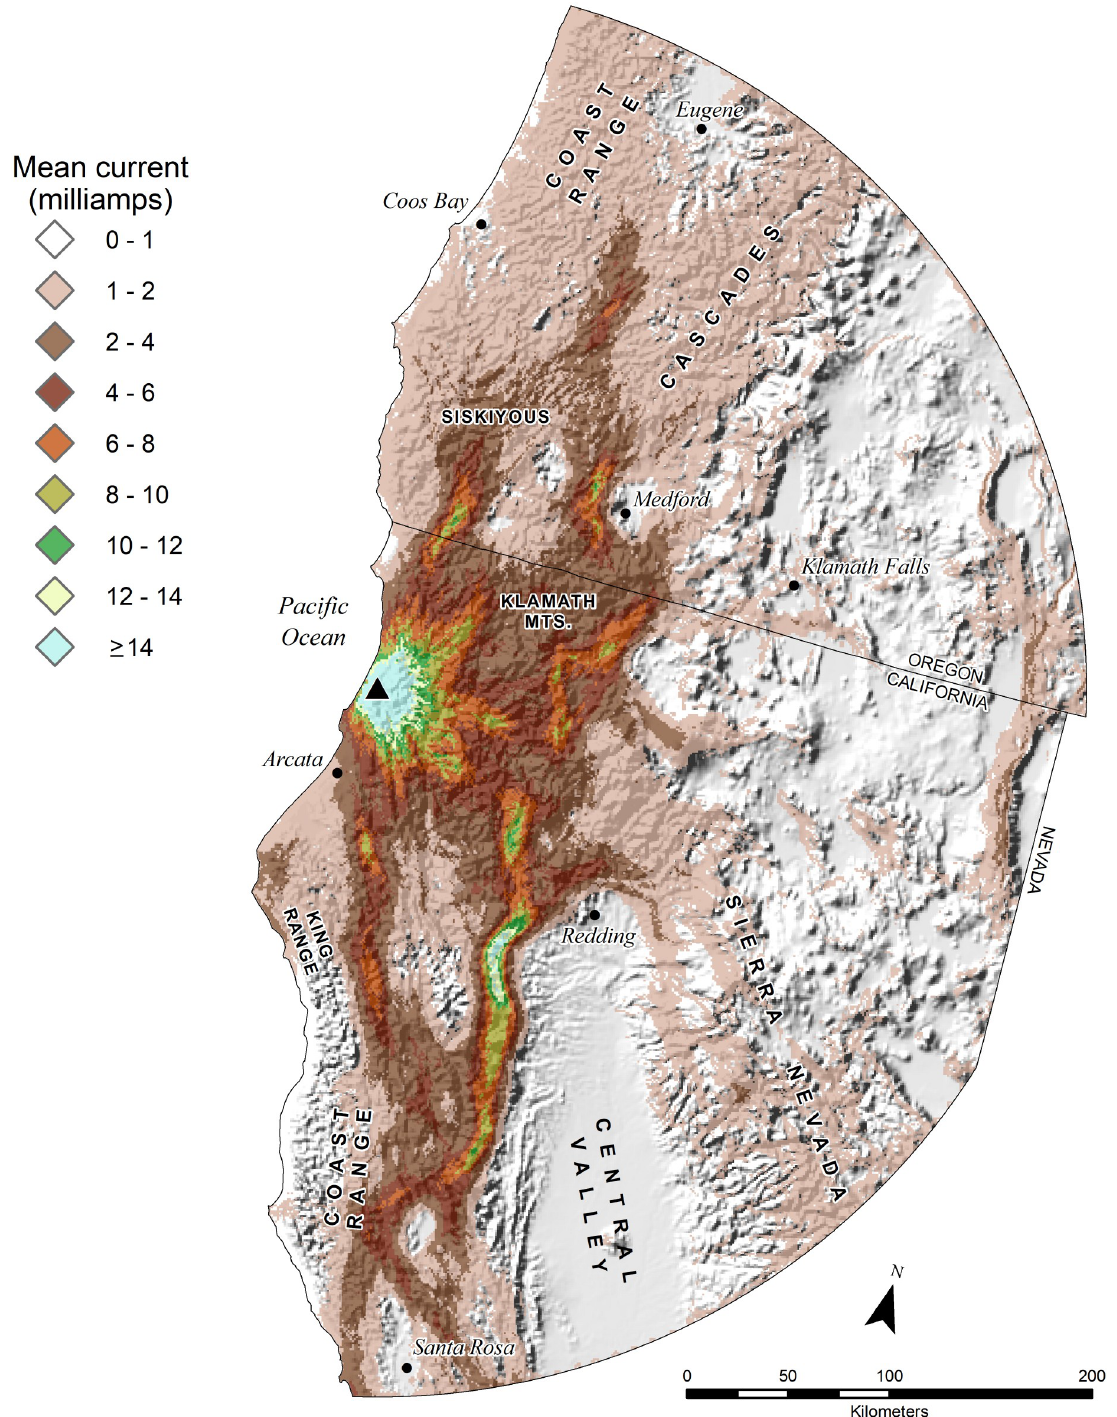
Fig 5. Mean electrical current for a California condor circuit theory model around a proposed release site ( ▲ ) in northern California, USA.